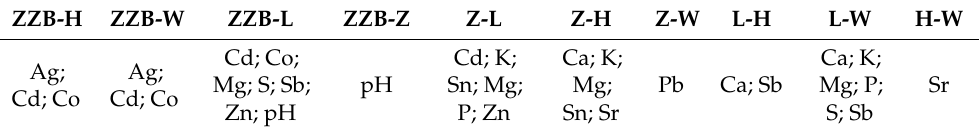
Table 6. The list of positively verified statistically significant differences for studied beer brands ( n =